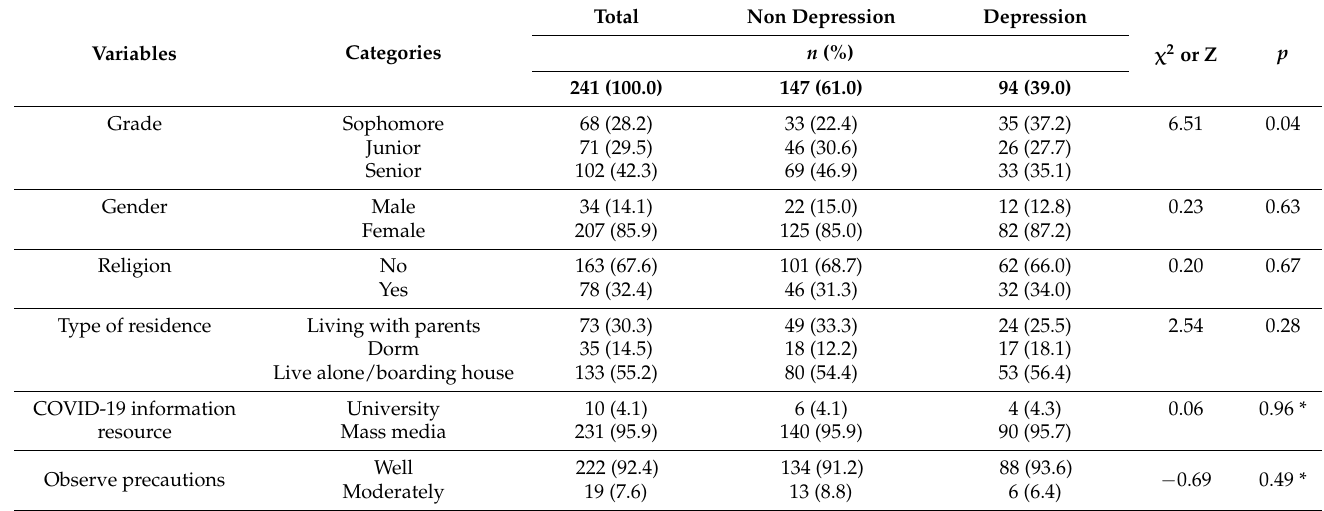
Table 1. General characteristics of the participants.